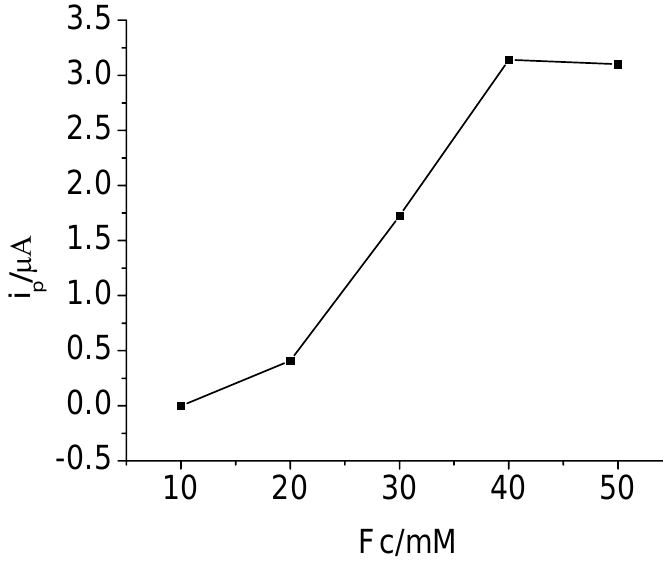
Figure 1. Influence of ferrocene concentration on the biosensor response studied by amperometric measurement for 9.68×10 -5 M H